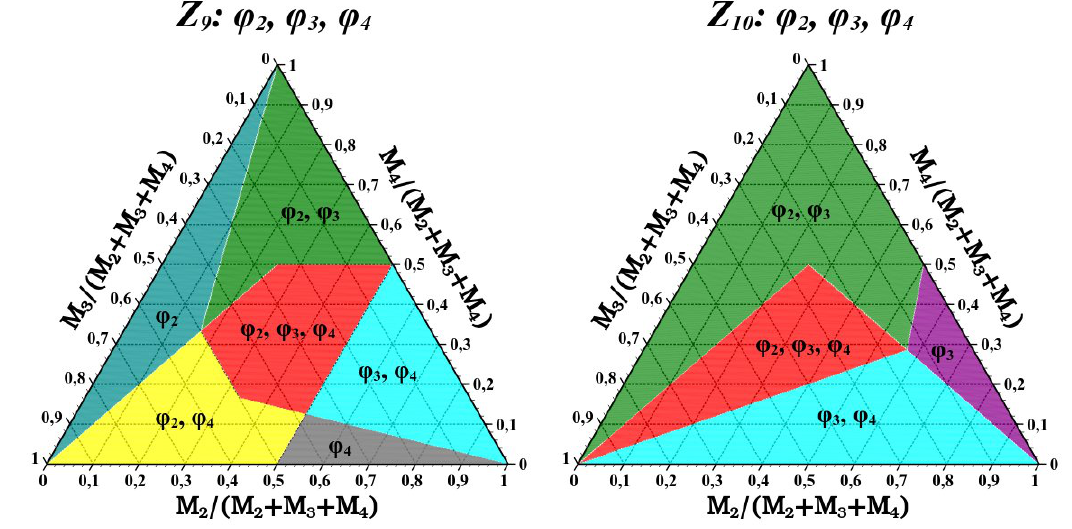
Figure 5 . Stability regions for a Z 9 (left panel) and Z 10 (right panel) symmetry with (cid:12)elds (cid:30) 2 ; (cid:30) 3 ; (cid:30) 4